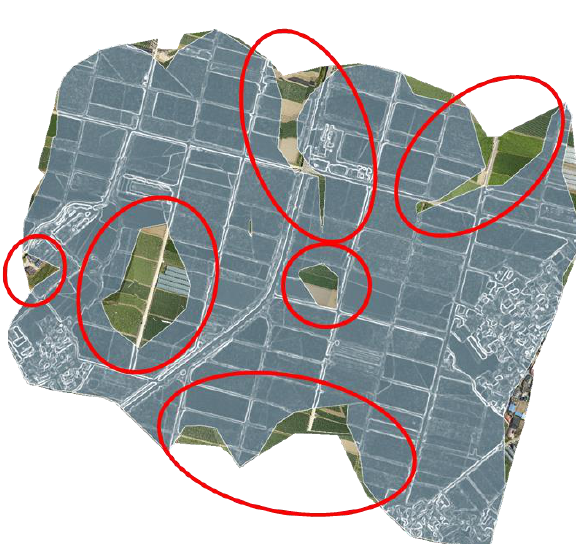
Figure 10. supplemented area on the result